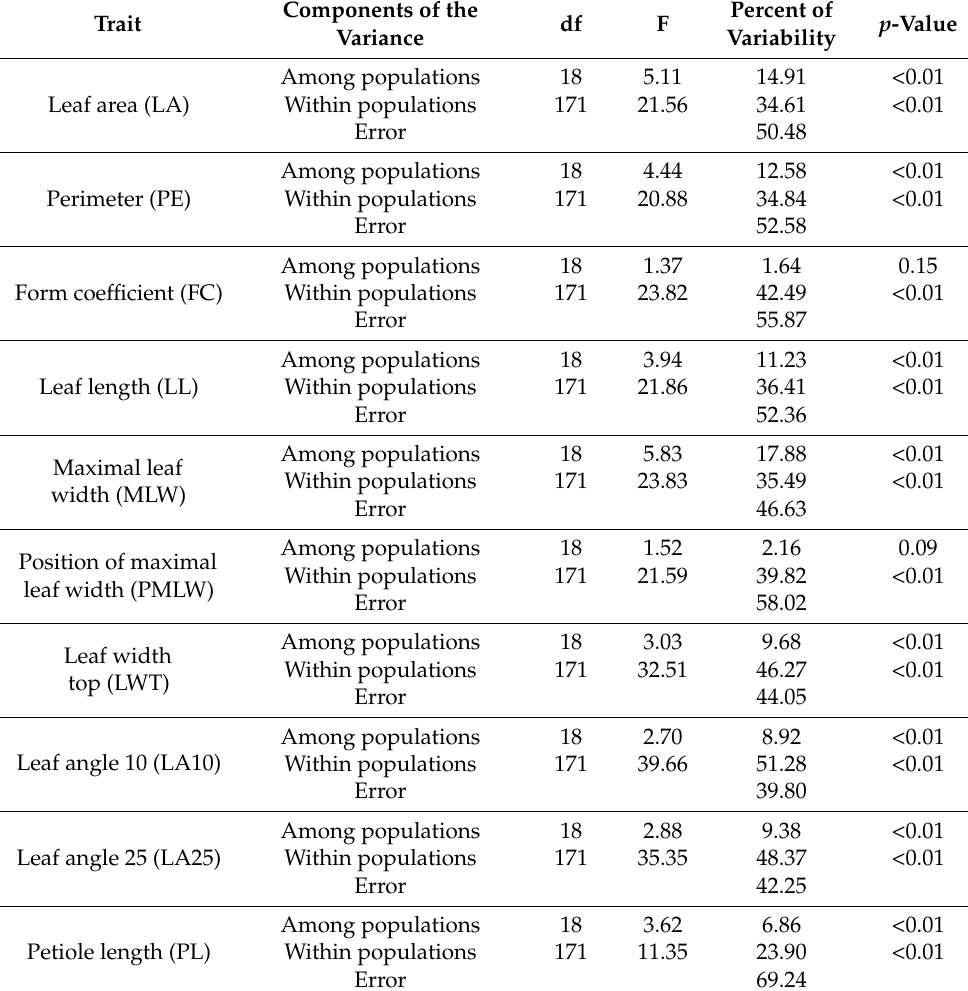
Table 2. Results of the hierarchical analysis of variance for studied leaf phenotypic traits. Components of the Trait